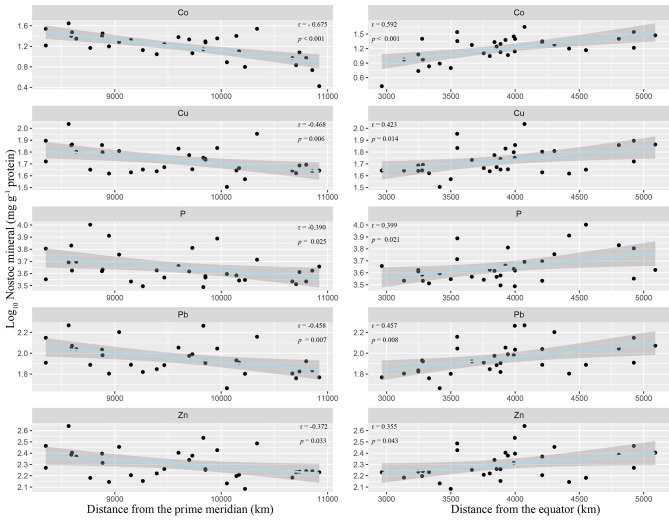
Geographic patterns of N. commune minerals in China. Five minerals show significant latitudinal (distance from the equator at certain longitude) and longitudinal (distance from the prime meridian at certain latitude) linear correlations (p < 0.05).